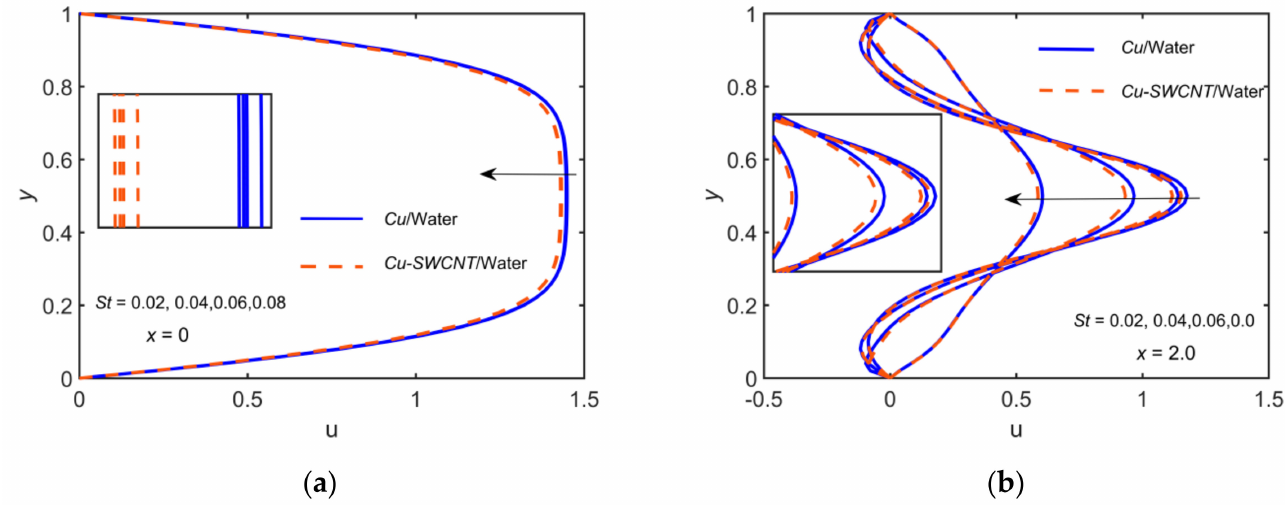
Figure 10. Comparison of Cu /water and Cu – SWCNT /water for the velocity profiles for t = 0.02, 0.04, 0.06, and 0.08 with M = 5, Pr = 1, Rd = 0.2, Re = 700, φ = 0.02, and t = 0.25 at ( a ) x = 0 ( b ) x =